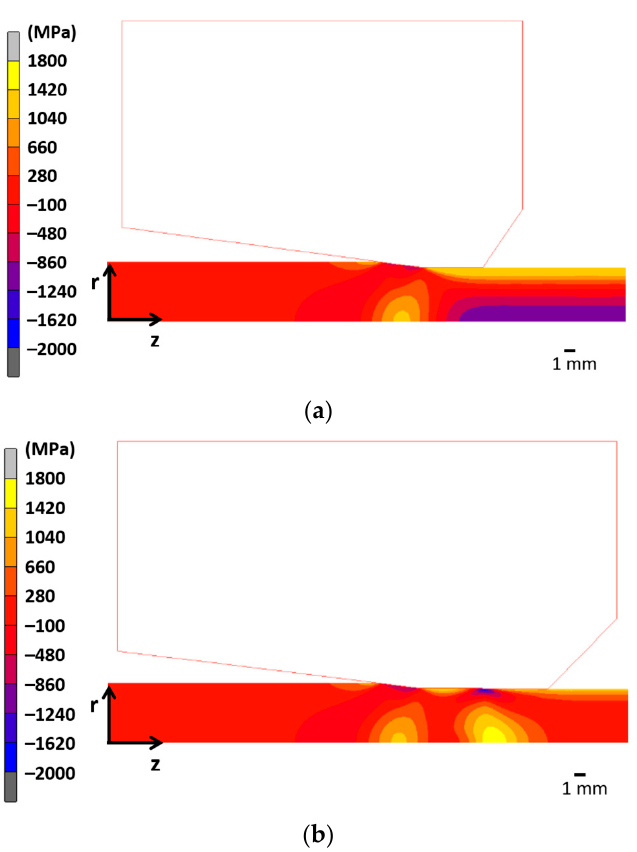
Figure 3. Axial stress fields obtained in: ( a ) a conventional cold drawing process and ( b ) a cold drawing with modified dies including a skin pass zone.